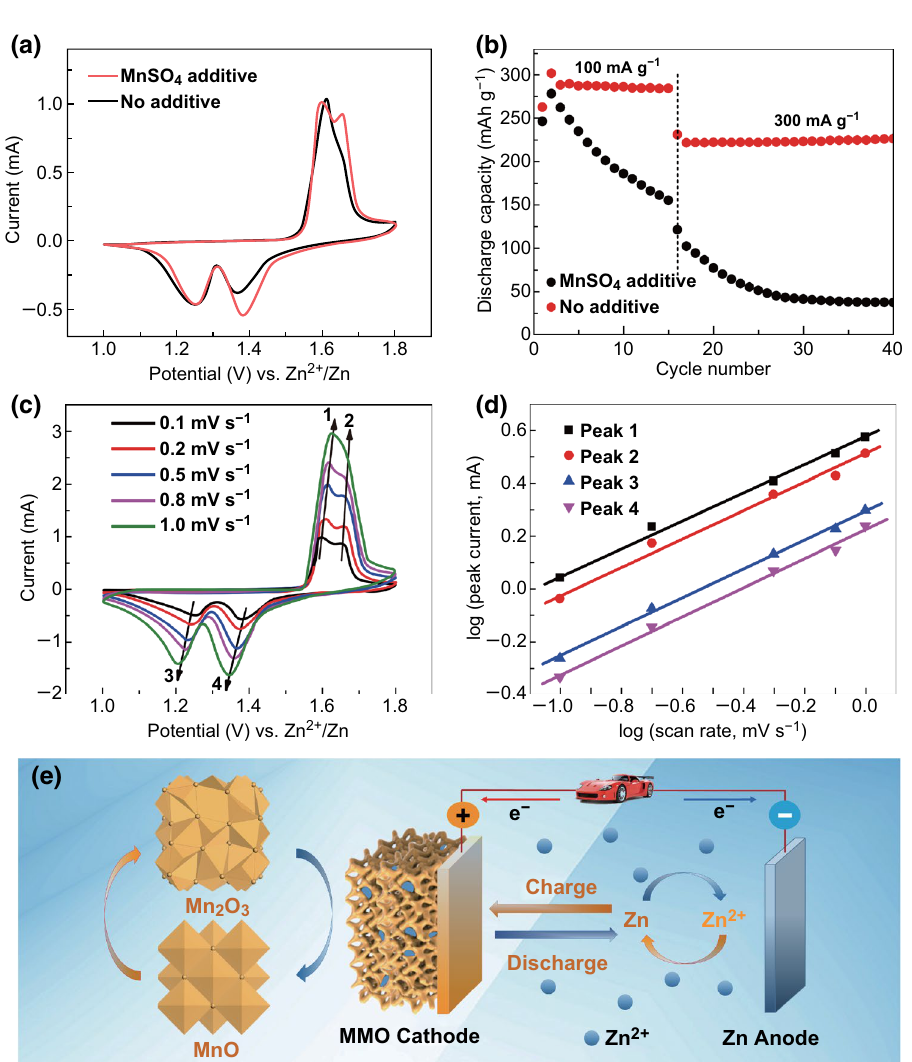
Fig. 5 Kinetic behavior of Zn/Mn 2 O 3 cells. a Comparison of CV scanning at 0.1 mV s −1 and b the cycling performance of MMO‑3.2 electrodes with and without MnSO 4 additive in ZnSO 4 aqueous electrolyte at about C/3 and 1C, respectively. c CV curves at different scan rates of 0.1, 0.2, 0.4, 0.8 and 1.0 mV s −1 . d Log i versus log v plots at specific peak currents. e Illustration of charge/discharge process for Zn/Mn 2 O 3 aqueous rechargeable